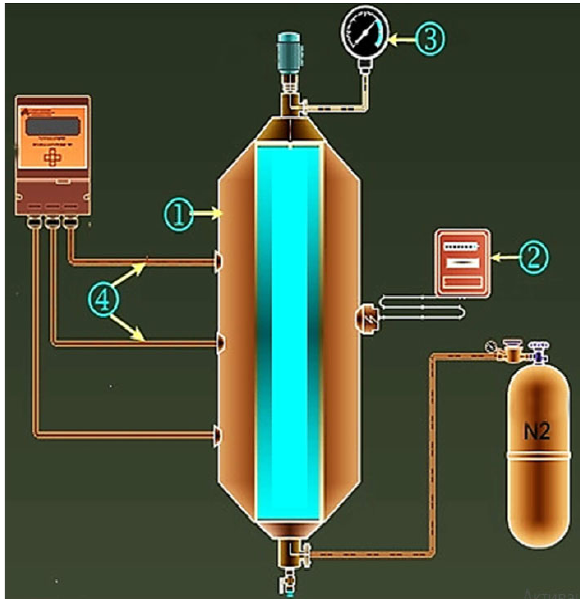
Figure 7. Schematic illustration of laboratory high-pressure reactor: 1—autoclave; 2—temperature- controlling unit; 3—manometer; 4—thermocouples.